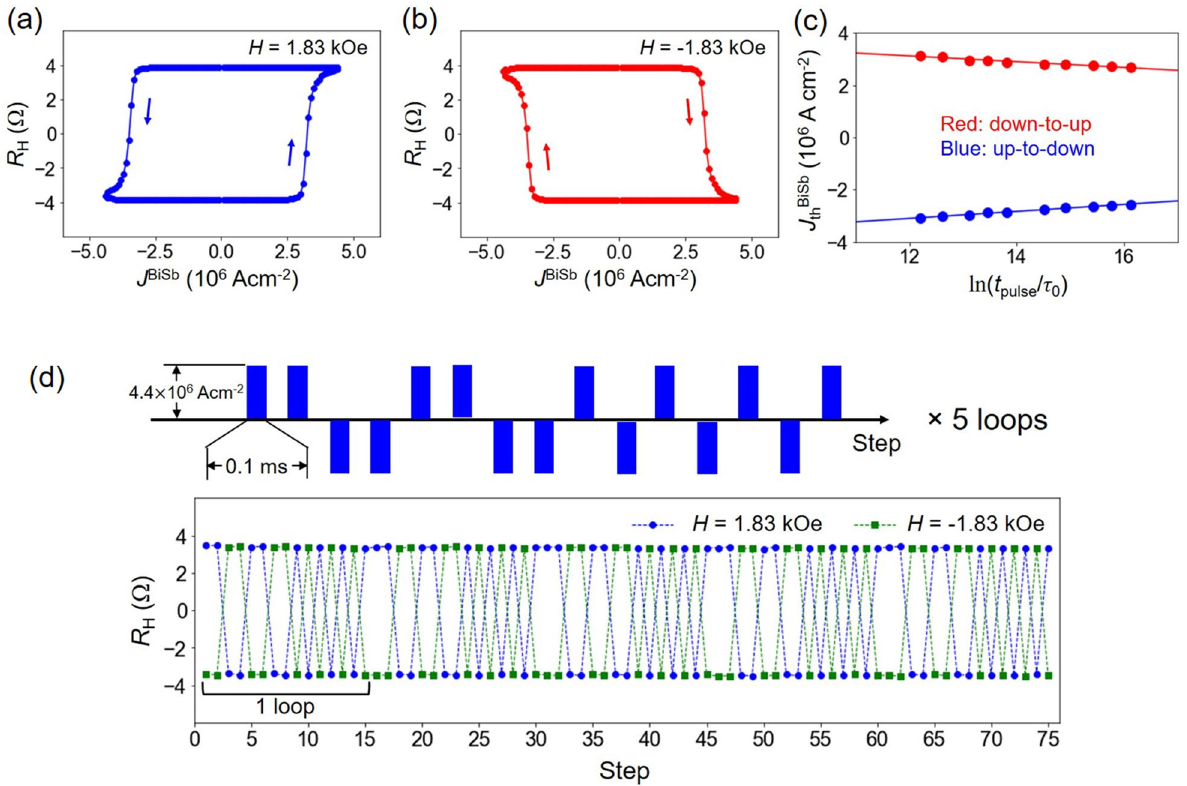
Figure 4. SOT magnetization switching by pulse currents. ( a , b ) Switching loop by 0.1 ms pulse currents under an in-plane magnetic field of H = + 1.83 kOe and − 1.83 kOe, respectively. ( c ) Threshold current density J function of t pulse . ( d ) Robust SOT magnetization switching by 0.1 ms pulse current.